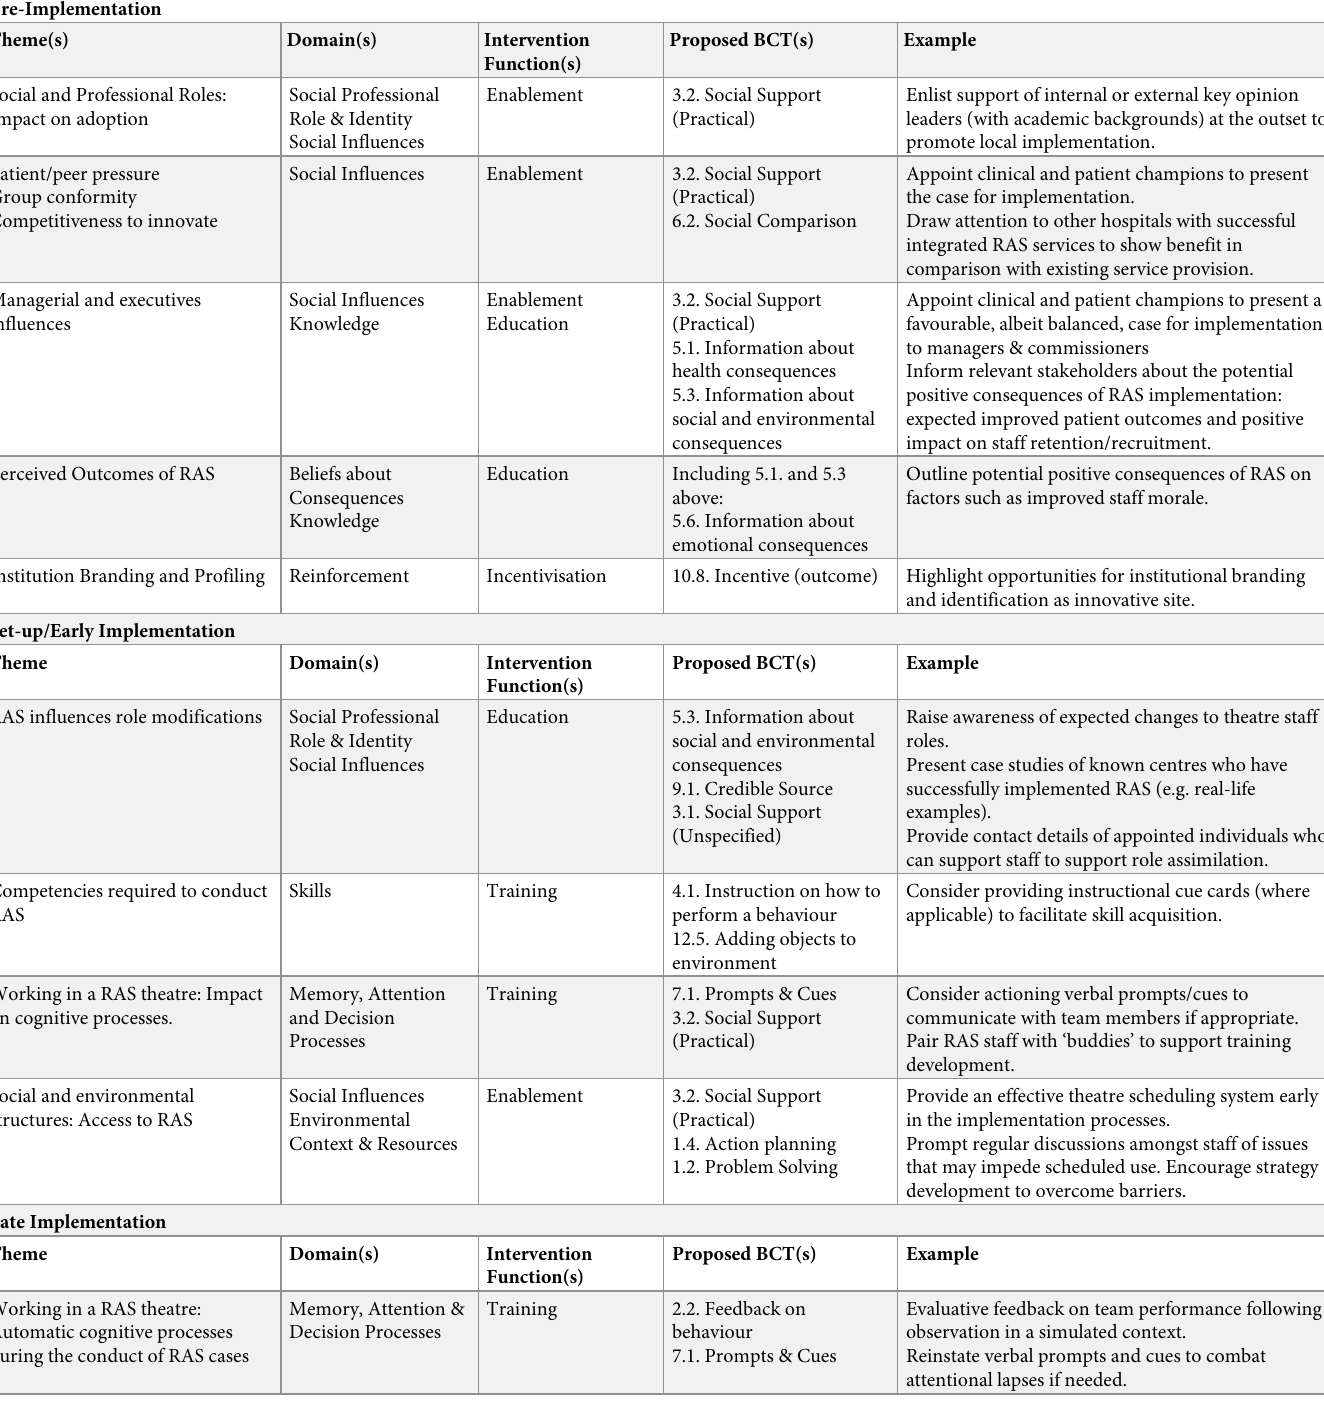
Table 2. Suggested strategies designed to optimise implementation, linked to interview themes and theoretical (TDF)